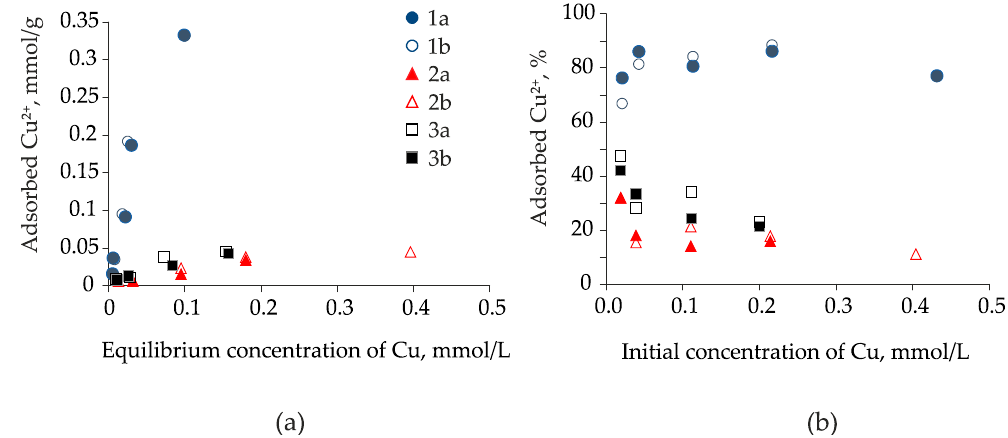
Figure 4. The dependence of the sorption of Cu(II) in mmol/g ( a ) and % ( b ) on the concentration of the initial solution. 1, 2, 3 = Na-, HAl 13 - and Al13-bentonite, respectively. Empty and filled icons (a,b) = repetitions of the same experiment.